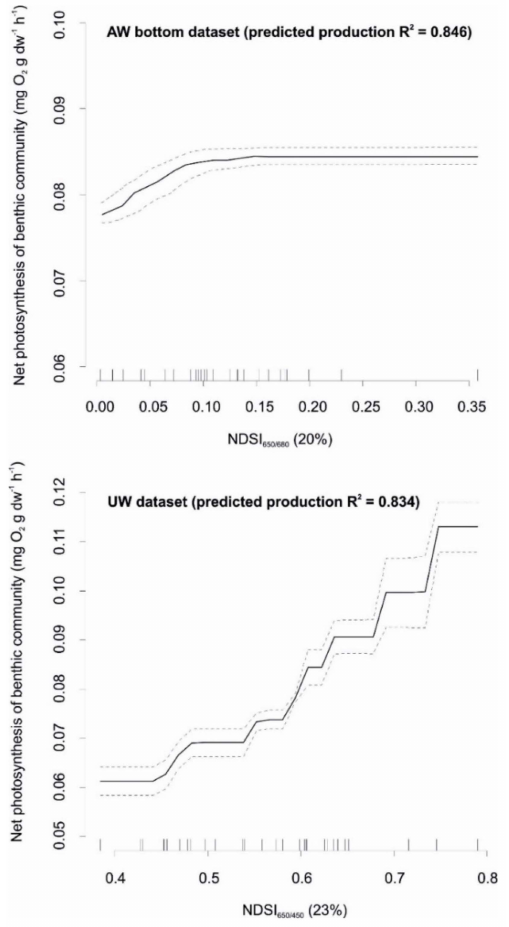
Figure 8. Standardized functional–form relationships ( ± standard error) showing the strength (% value in brackets) and shape of relationship between best performing spectral indices and the net photosynthesis of the studied plant classes, whilst all other variables are held at their means. Upward tickmarks on x -axis show the frequency distribution of data along this